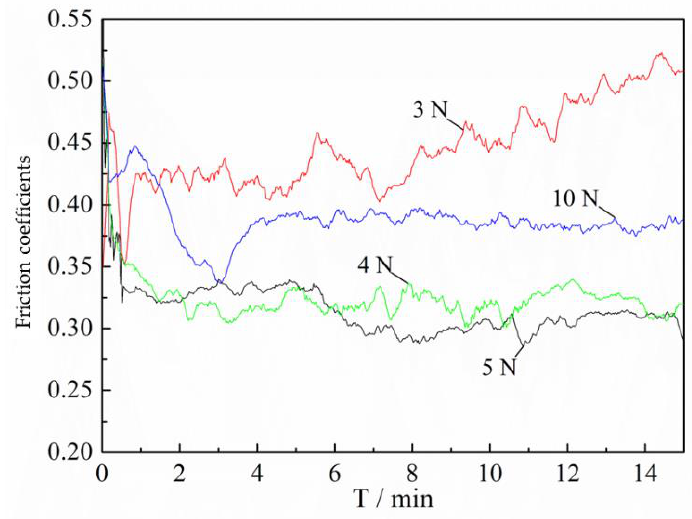
10 of 14 Table 5. Wear rate parameters under different loads.